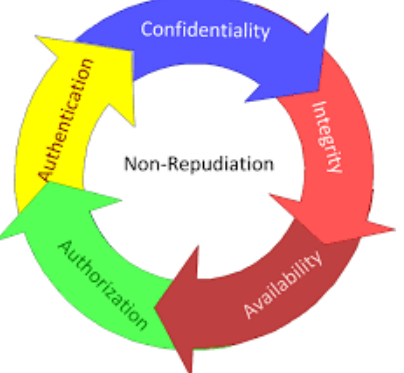
Figure 4:Goals of system information security